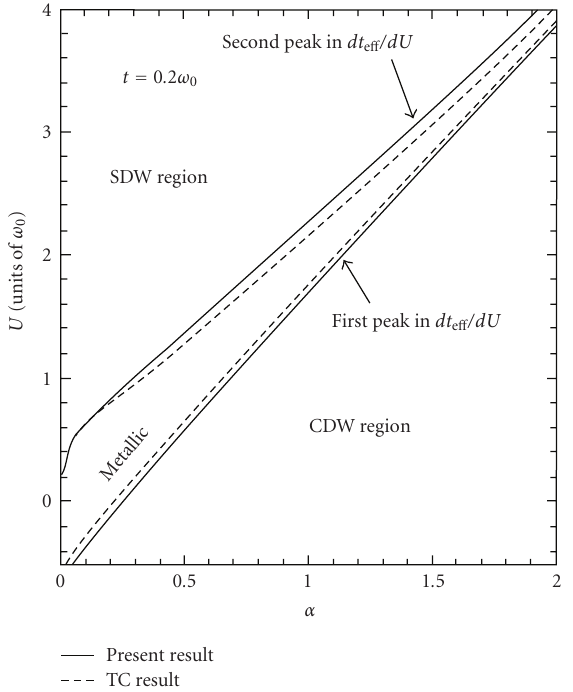
Figure 10: Phase diagram in ( α , U ) determined by the peaks in dt e ff /dU . The corresponding phase diagram obtained by TC in [44] is shown in dashed lines for